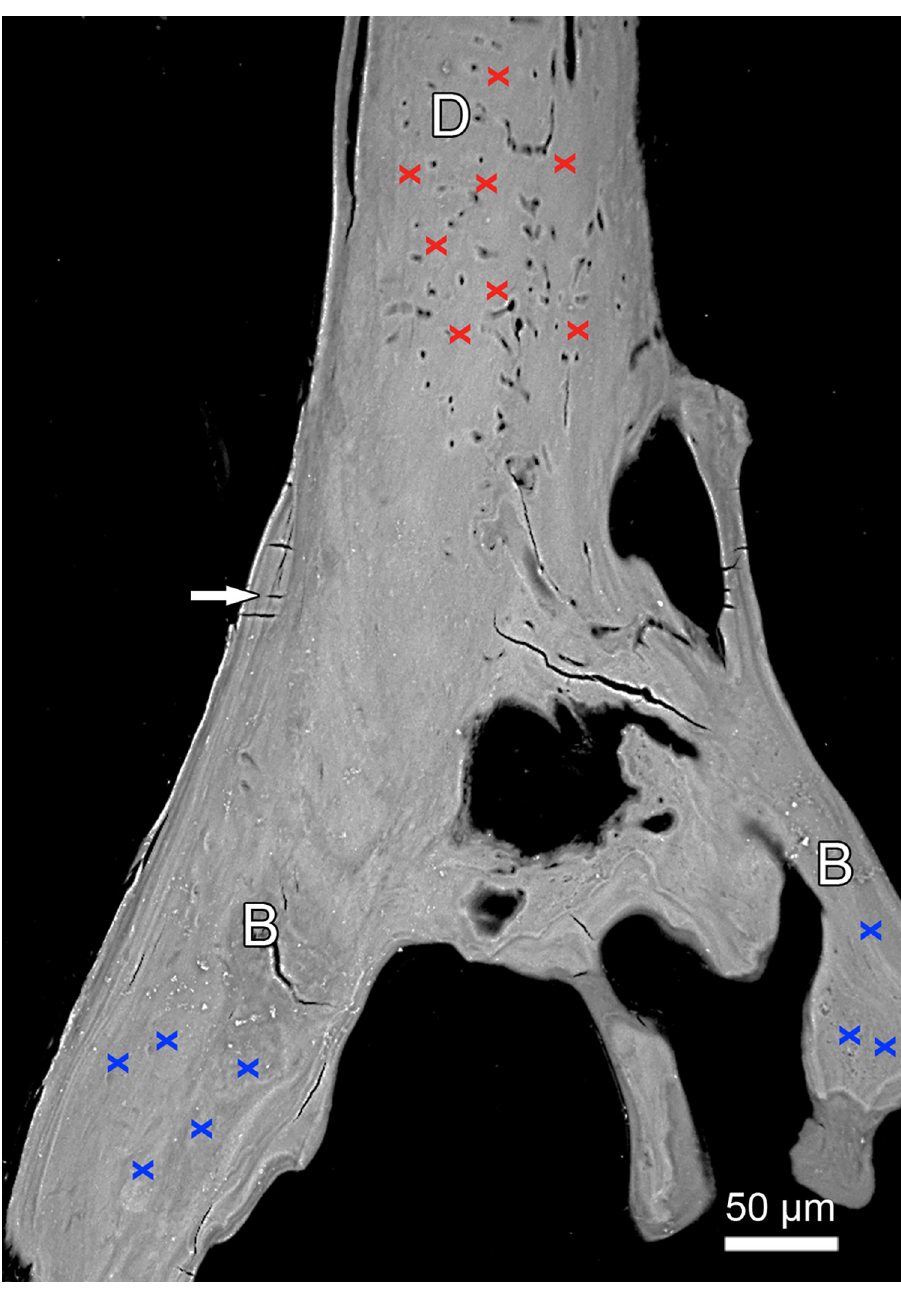
Fig 8. SEM-BSE image of polished longitudinal section through basal portion of left first dentary tooth and adjacent bone of attachment. Location of SEM-EDS point measurement spots is indicated by red crosses in the dentin (D) and blue crosses in the bone of attachment (B). Note lack of osteocyte lacunae in the bone of attachment. Arrow: Mineralized collagen